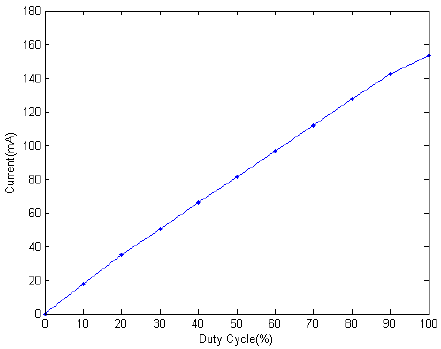
Figure 8. Duty cycle versus current curve.